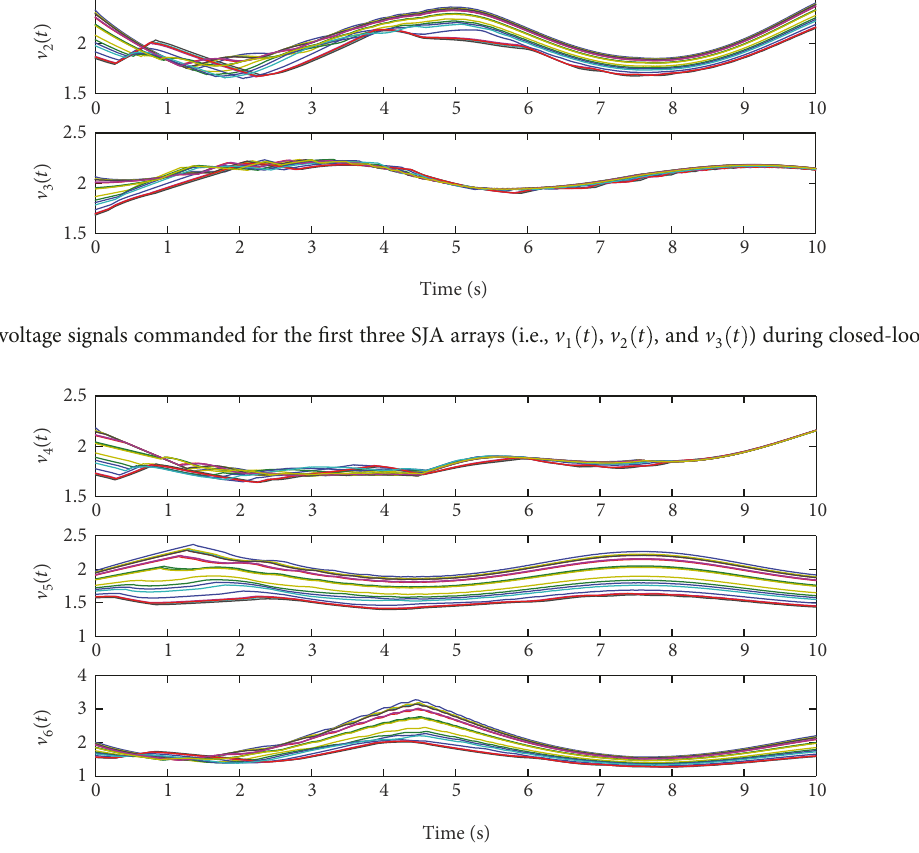
Figure 8: Control voltage signals commanded for the last three SJA arrays (i.e., v